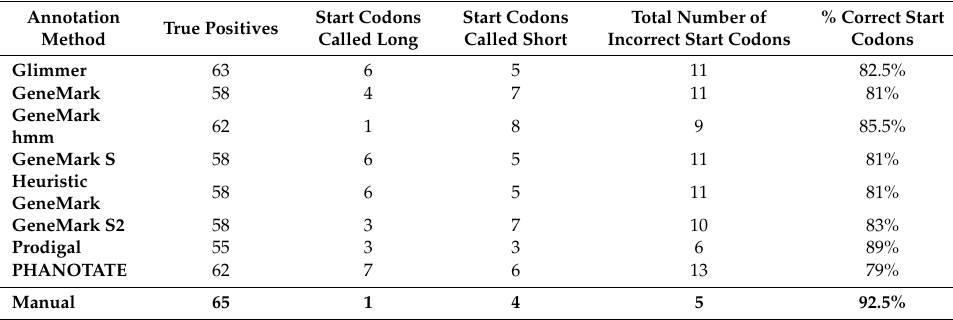
Table 3. Results of start codon identification in the genome of phage Lambda.